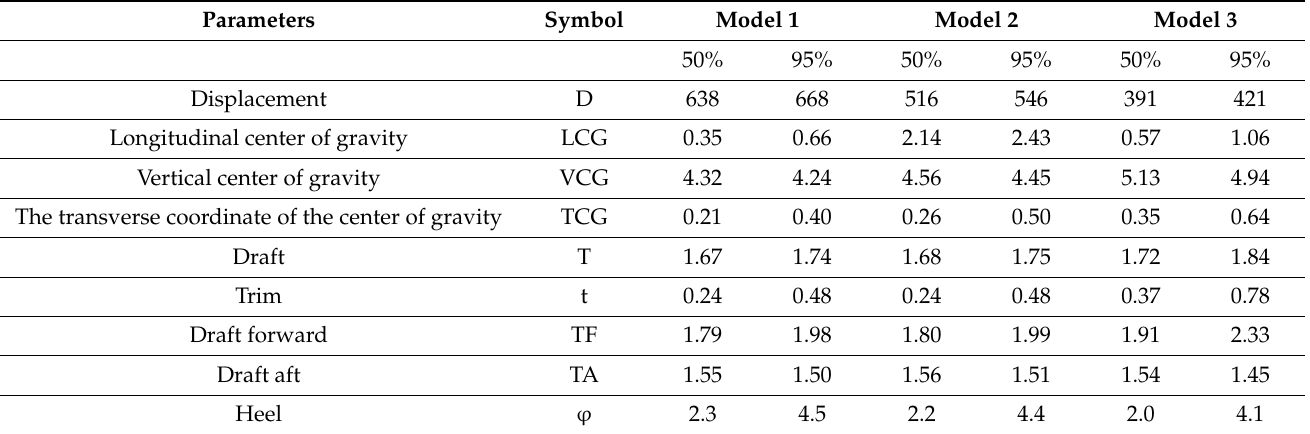
Figure 10. Values of the vessel’s capsizing coefficient (C) depending on the trim and its rolling. In the case of unsymmetrical flooding (Table 6), the flooding of a watertight compart- ment up to 95% of its capacity, causes heels of about 4 ◦ (Figure 11). The capsizing of the vessel 1 and 2 occurs at a rolling of 12 ◦ –13 ◦ . On the other hand, the capsizing of the vessel 3 is possible at 10 ◦ . Table 6. Parameters of vessels after unsymmetrical flooding of